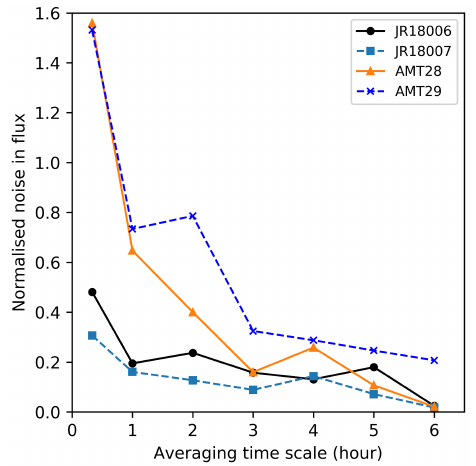
Figure 8. Effect of the averaging timescale on the noise : signal (random noise in flux / natural flux variability) for EC air– sea CO 2 flux measurements during four cruises.